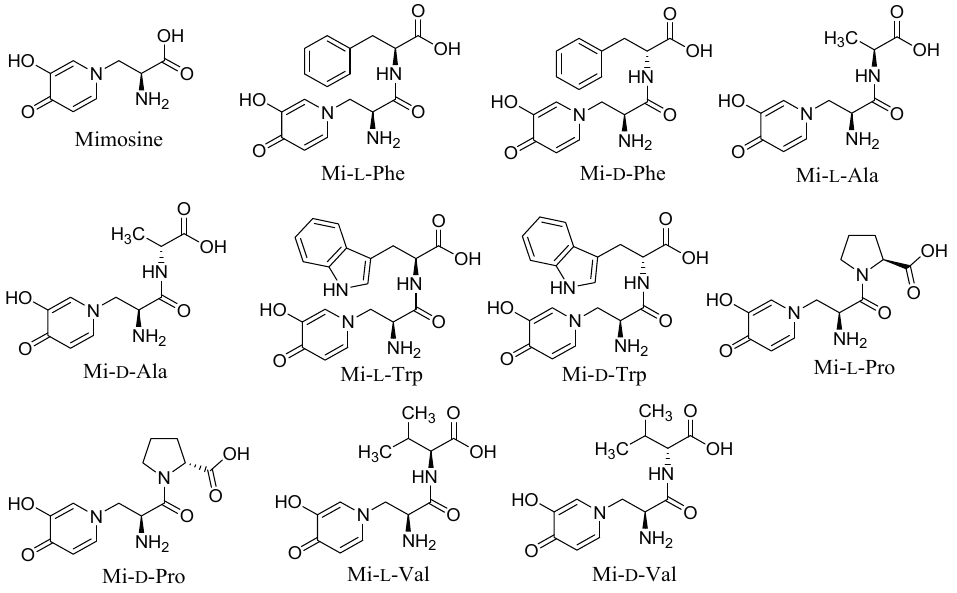
Figure 1. General route of mimosine dipeptide synthesis. ( AA ) L - or D -amino acid; ( A ) L -mimosine isolation from Leucaena leucocephala leaves using ion-exchange resin; ( B ) Preparation of Fmoc-mimosine; ( C ) Attachment of Wang resin to Fmoc-amino acid; ( D ) Deprotection of Fmoc using 25% piperidine; ( E ) Coupling of Fmoc-mimosine and amino acid-resin mixture along and the Kaiser test; ( F ) Deprotection and cleavage using 95% trifluoroacetic acid (TFA) to afford desired mimosine dipeptides.